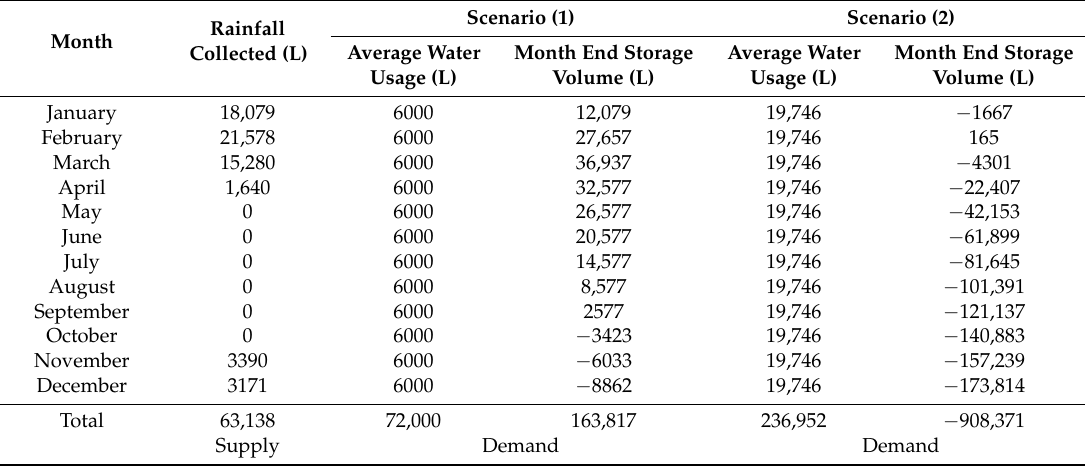
Table 8. Monthly rainwater supply for scenarios (1) and